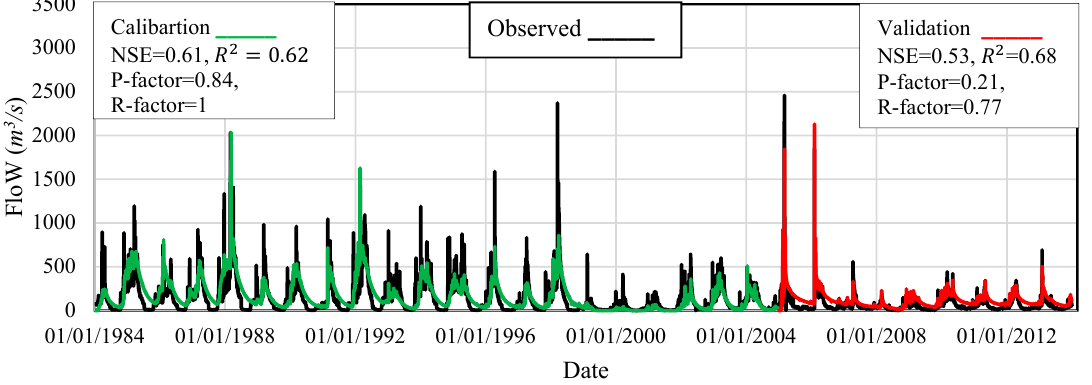
Figure 6. Calibrated and validated streamflow of the Derbendkhan Watershed.